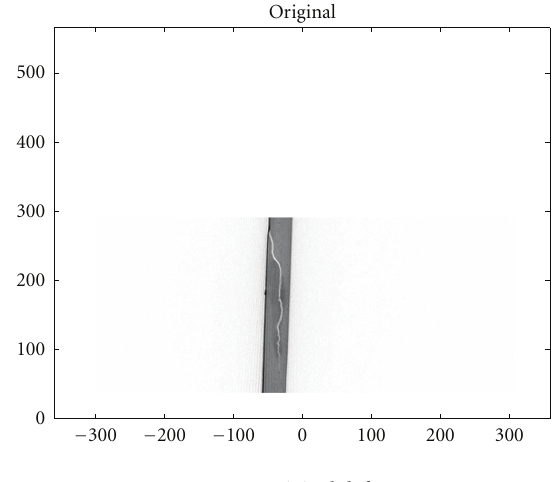
Figure 5: Original